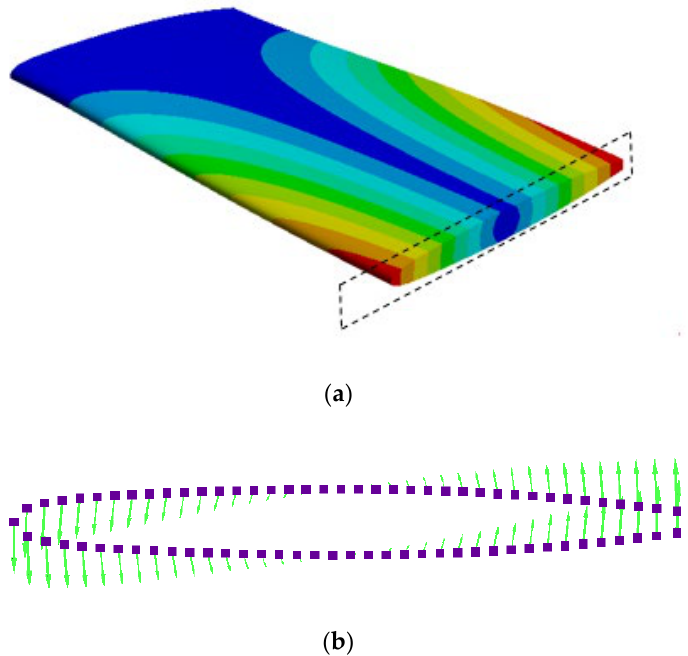
Figure 1. ( a ) Normalized mode shape with the selected section highlighted in black and ( b ) the CFD model with the imported mode shape section.